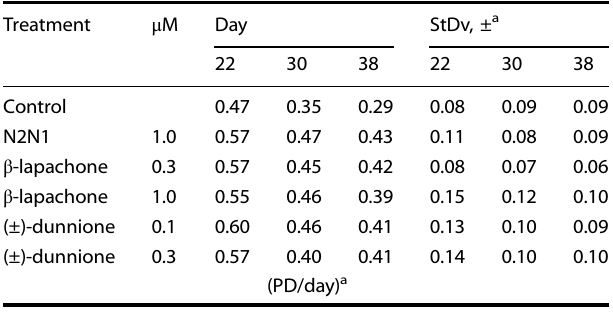
a Average and standard deviation values were calculated from three independent experiments